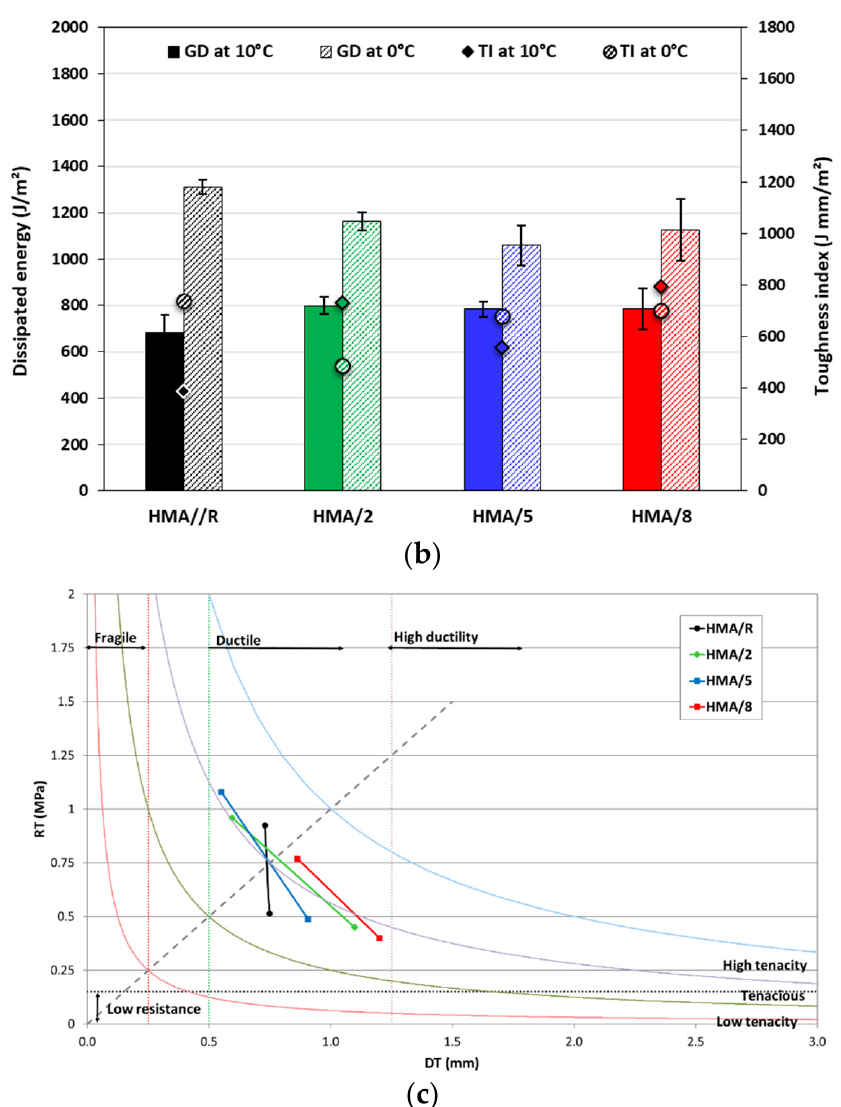
Figure 9. Fenix test parameters: ( a ) Maximum tensile force vs. Displacement at 50% of post-Fmax; ( b ) Dissipated energy vs. Toughness Index; ( c ) Fenix Stress-Strain Diagram©. Temperatures 0 ◦ C and 10 ◦ C. (The Fenix diagram is associated with a test methodology. 2019 UPC all Rights